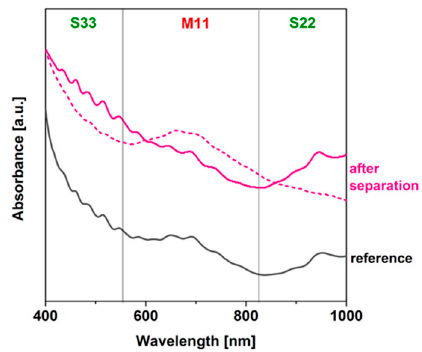
Figure 3. ATPE of large-diameter single-walled carbon nanotubes (CNTs) without addition of hydration modulators. Dextran-rich bottom phase (dashed line), PEG-rich top phase (solid line). Reference dispersion shown in